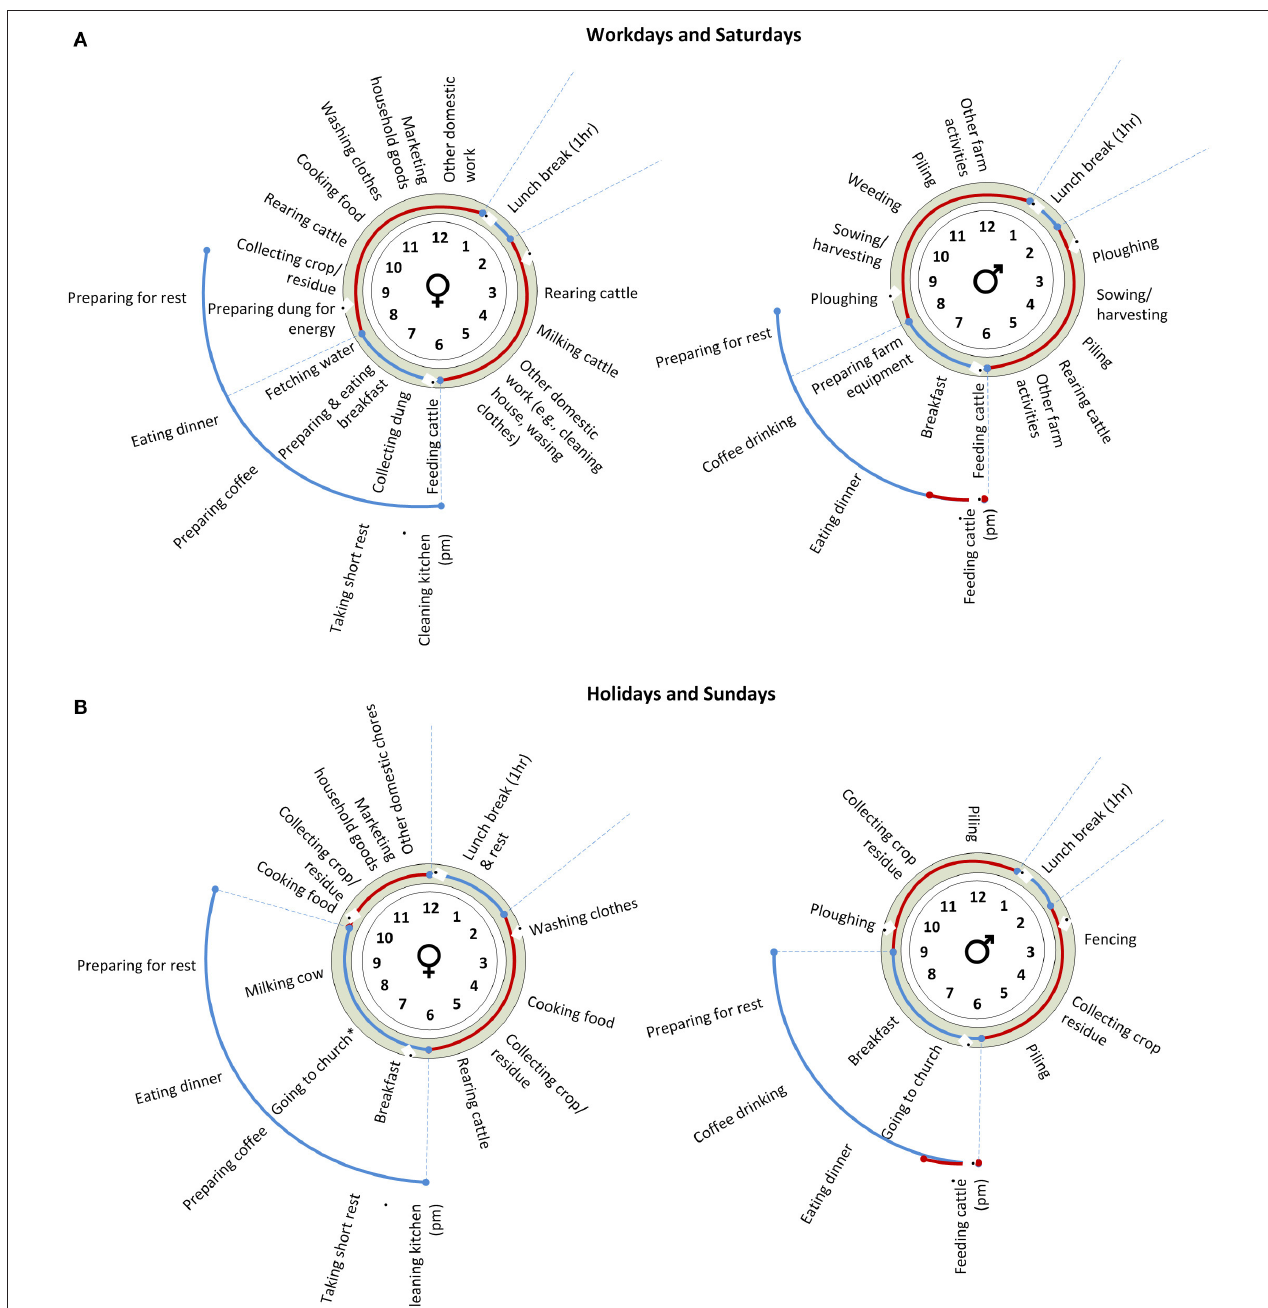
FIGURE 4 | Daily activity cycles of male and female farmers in the study area for (A) Workdays and Saturdays and (B) Holidays and Sundays.